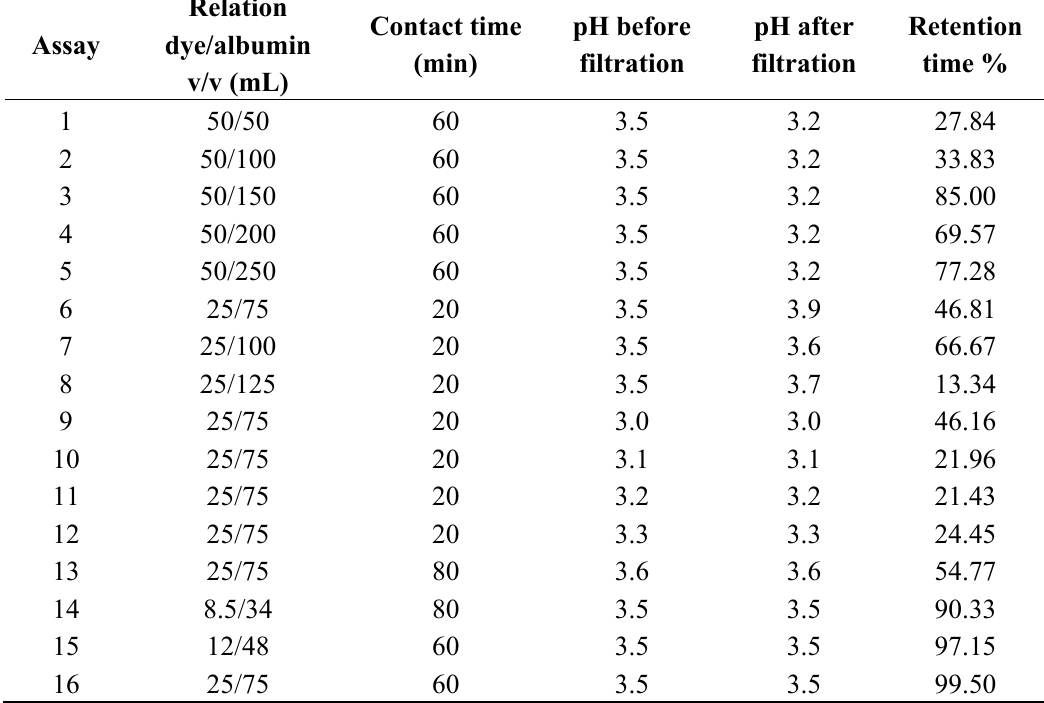
Table 3. Complete assays for removing Orange II related to the proportion of azo dye and albumin bath, contact time, pH before and after filtration.